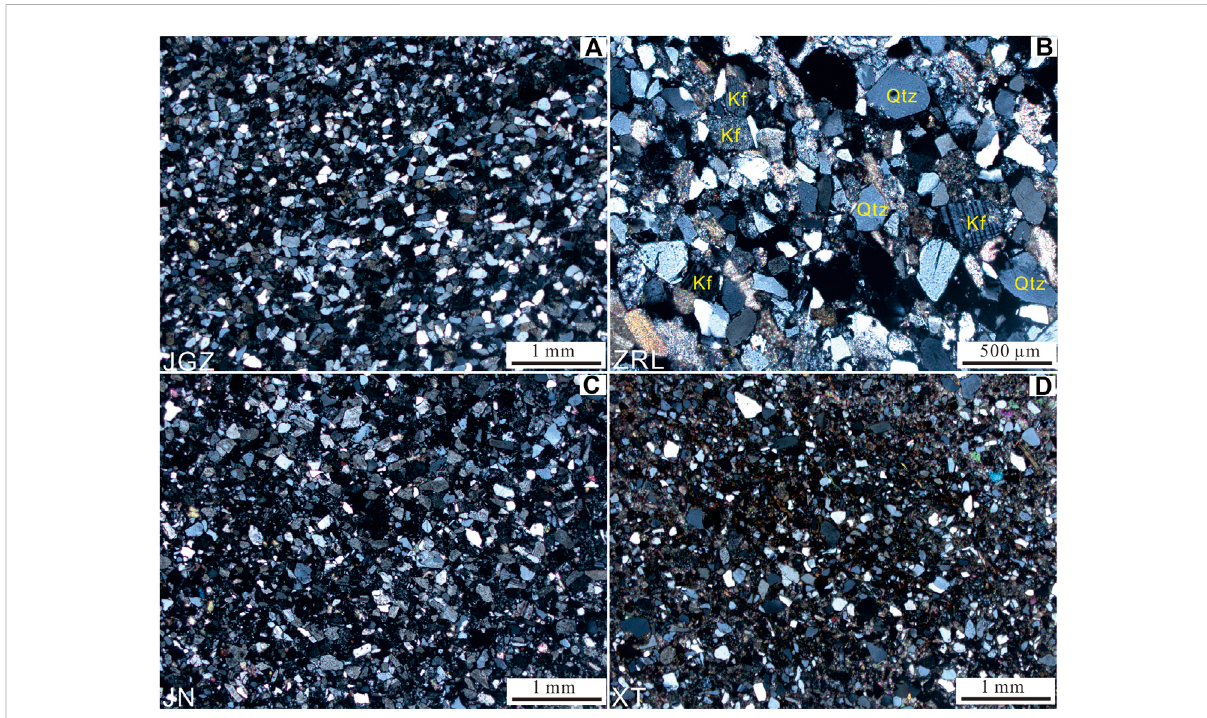
FIGURE 5 Microphotographs of the thin-sections showing the textures and mineral compositions of the four representative samples; (A) sample JGZ consisting of fi ne-grained quartz and feldspar with angular shapes, (B) sample ZRL consisting of intermediate-coarse grained quartz, K-feldspar and minor plagioclase grains with typical angular shapes; (C) sample JN consisting of fi ne-grained quartz and feldspar grains with angular shapes; (D) sample XT consisting of fi ne-grained felsic minerals and ma fi c minerals with typical matrix-supported